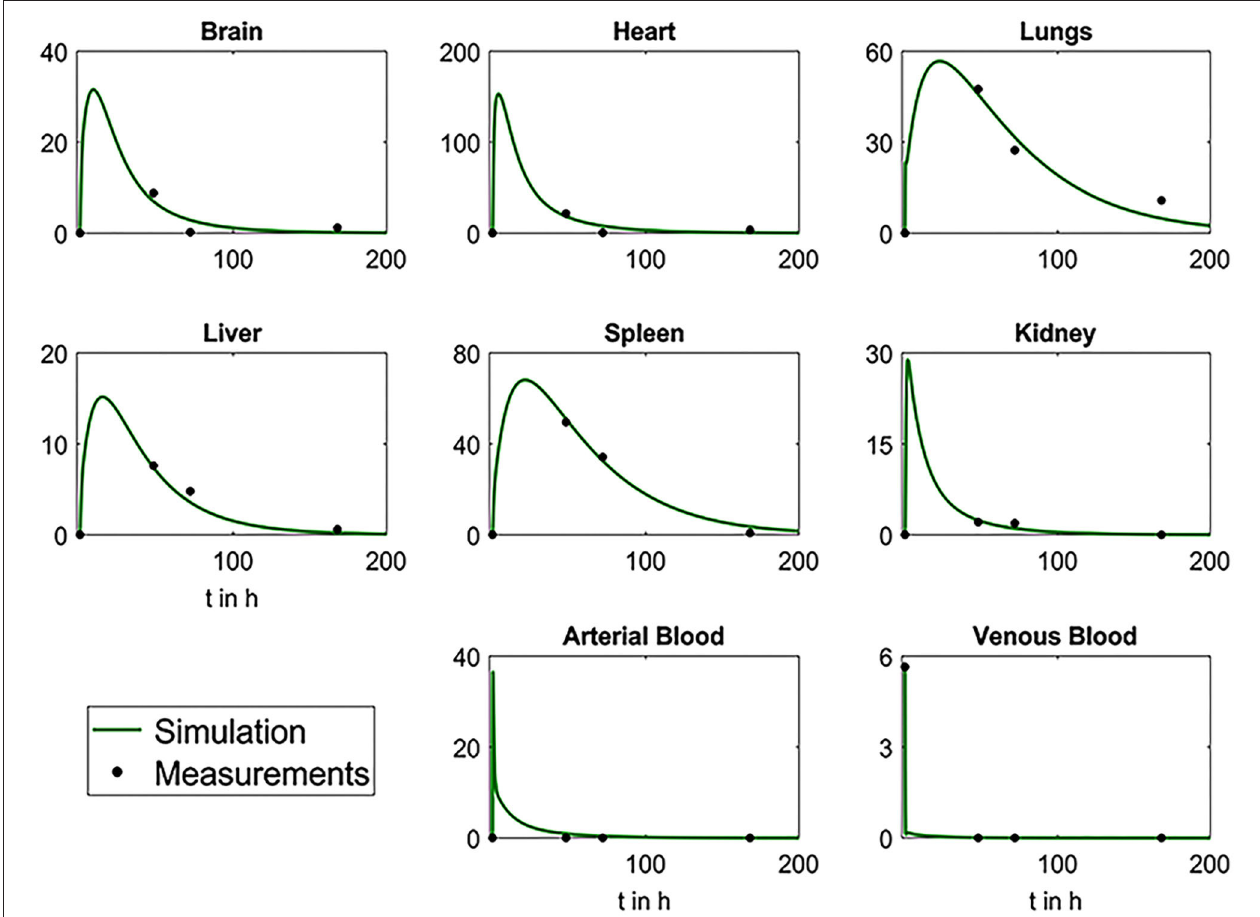
FIGURE 10 | Plots depicting the comparative analysis of biodistribution data and results from simulations with mathematical model. Black dots represent the mean values of the measured experimental data and green curves the simulation